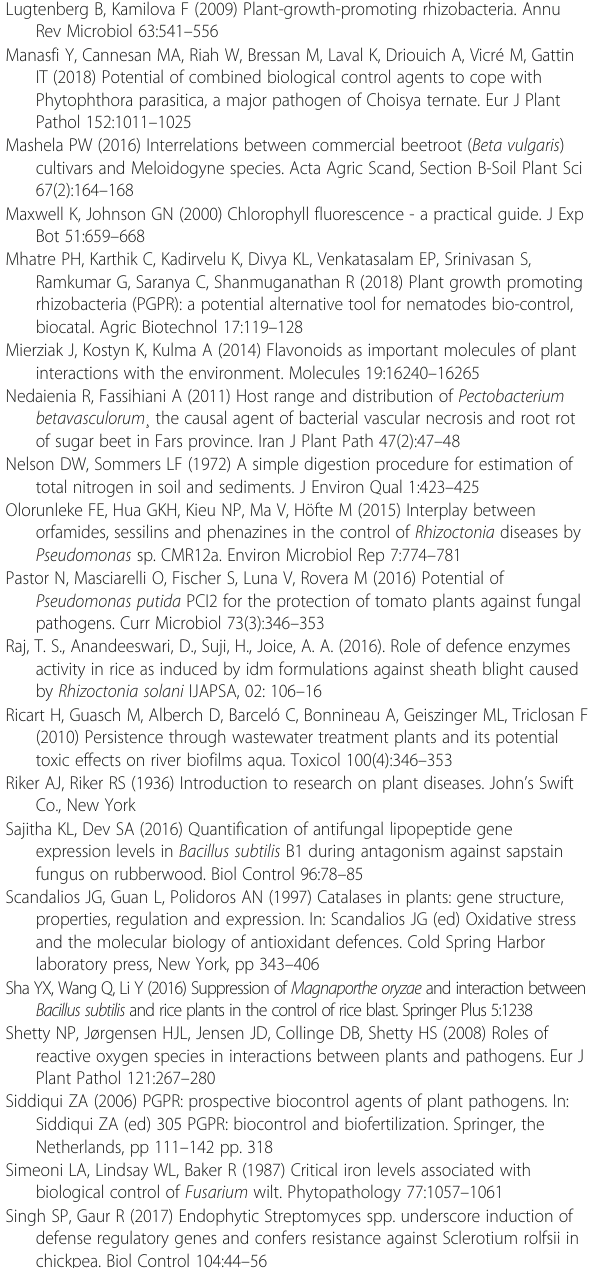
Tabatabaei FS, Saeedizadeh A (2017) Rhizobacteria cooperative effect against Meloidogyne javanica in rhizosphere of legume seedlings. Hellenic Plant Protect J 10:25 – 34 Tian SP, Wan YK, Qin GZ, Xu Y (2006) Induction of defense responses against Alternaria rot by different elicitors in harvested pear fruit. Appl Microbiol Biotechnol 70:729 –